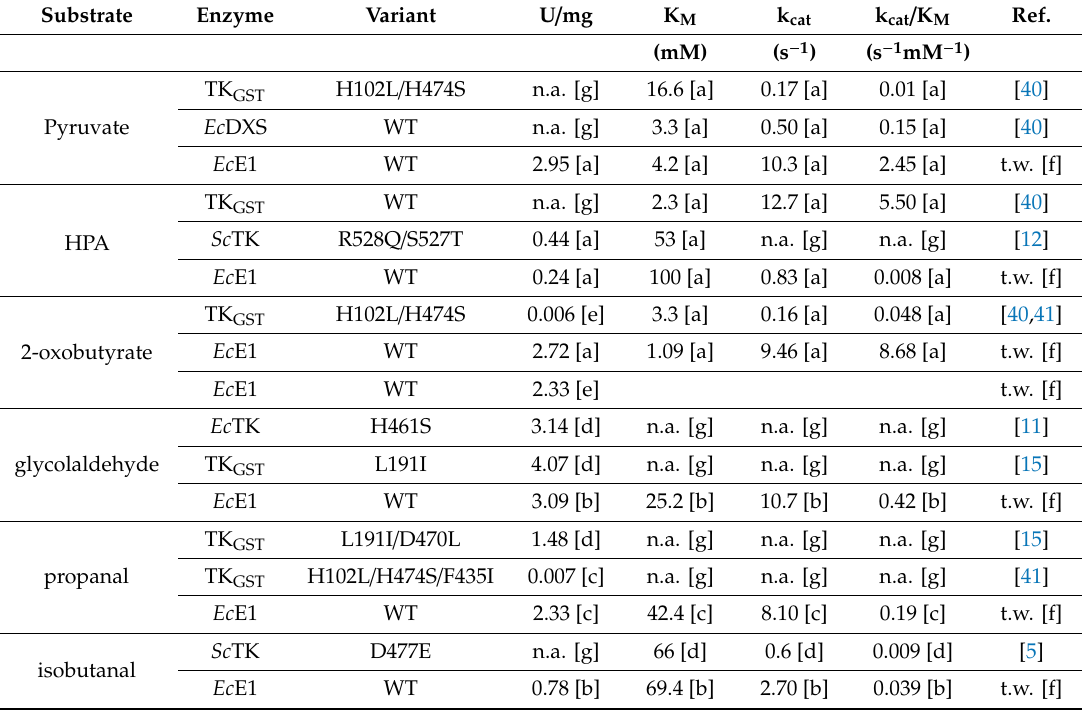
Table 2. Comparison of apparent kinetic parameters for di ff erent enzymes and